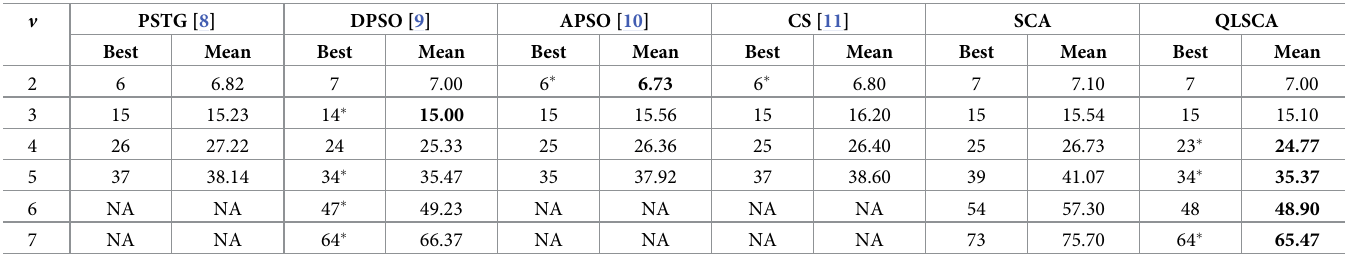
Table 7. Size performance for CA ( N ;2, v 7 ) where v is varied from 2 to